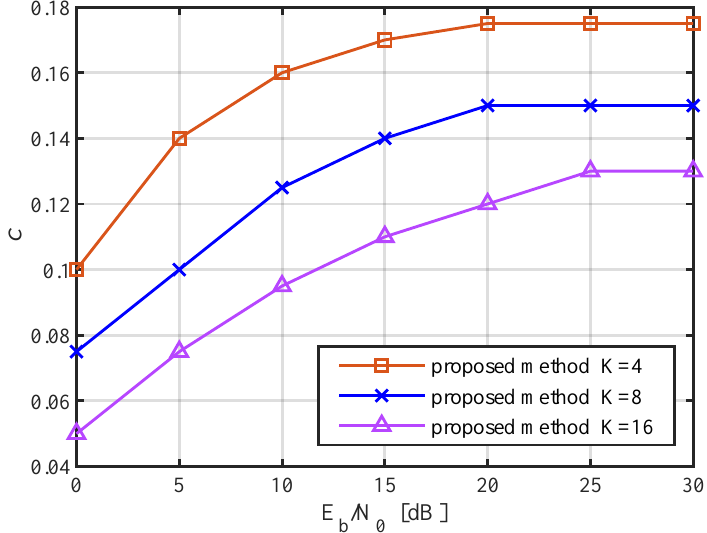
Figure 10. The values of c when the suboptimal BER performance is